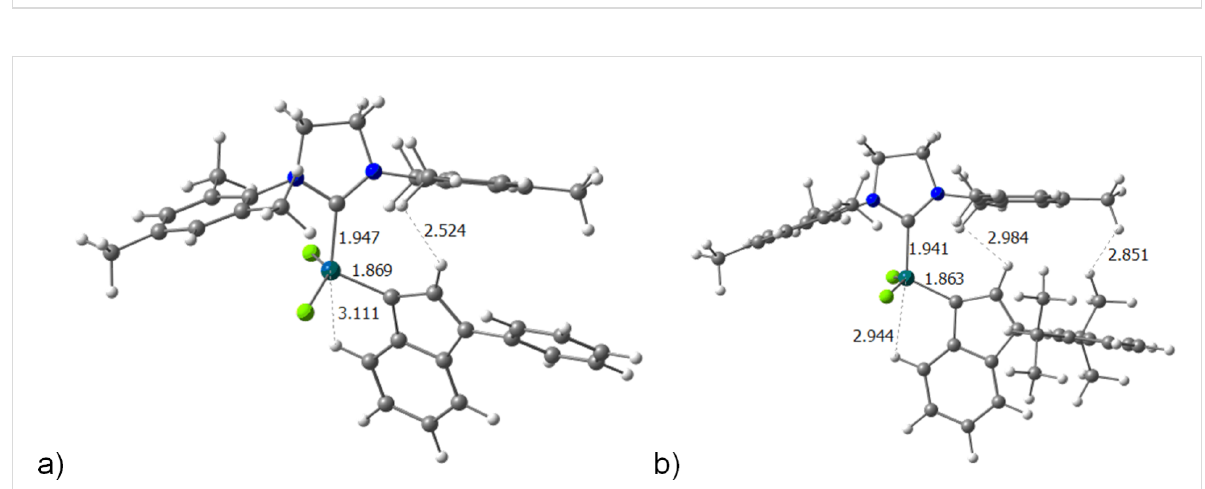
Figure 2: Intermediate II for catalysts a) 1 and b) 5 (important bond lengths are given in Å).